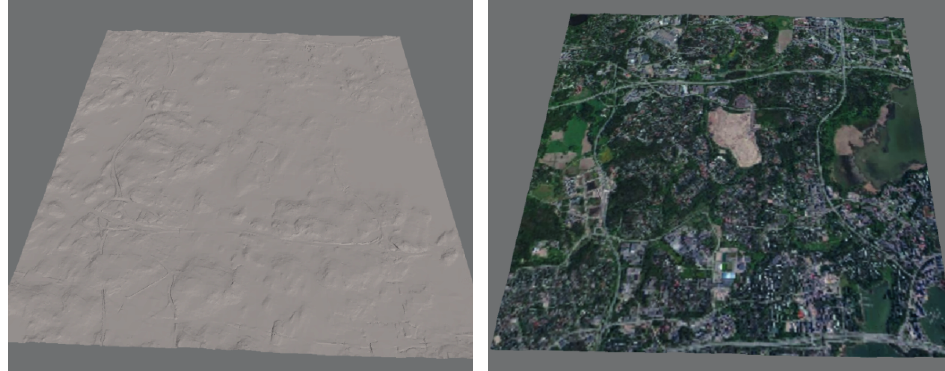
Figure 20. Terrain model for an area of 6 km × 6 km. ( Left ) terrain model without texture; ( Right ) terrain model with an orthophoto